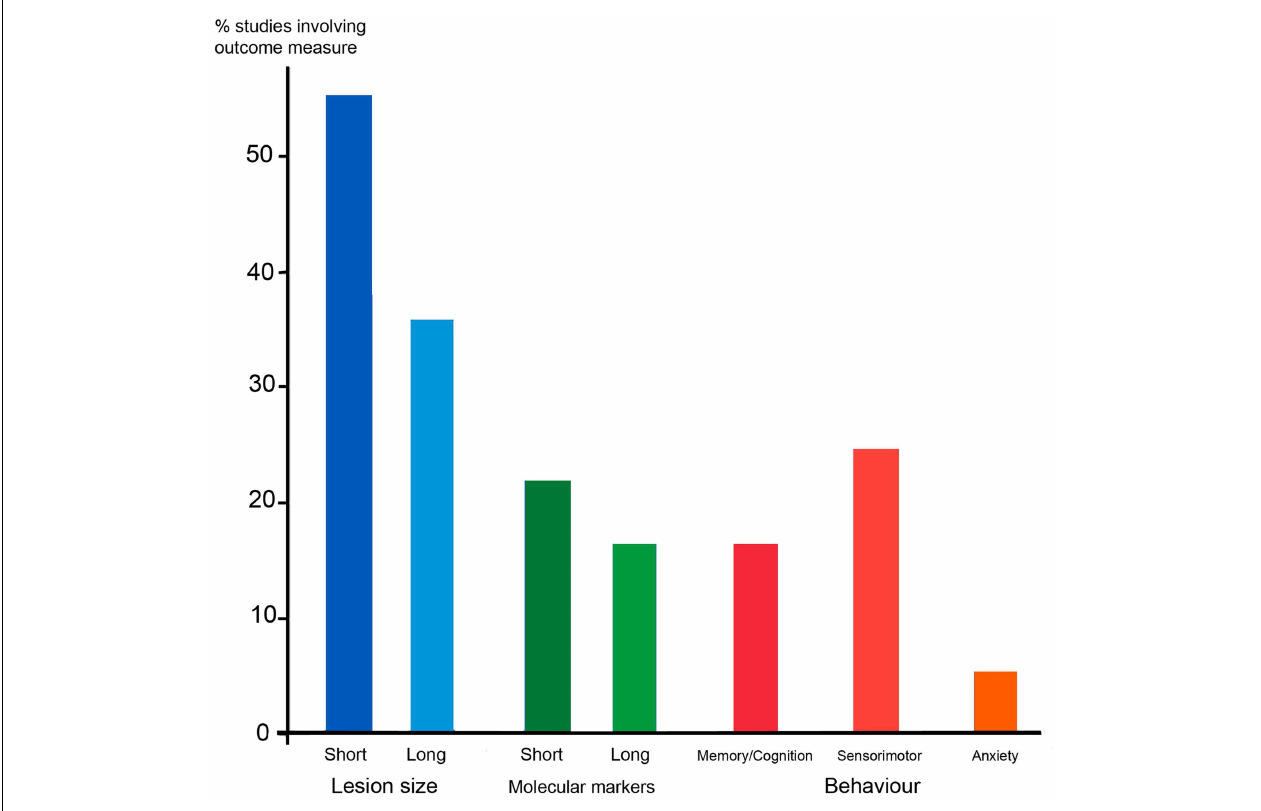
gliosis. Red/orange shows behavioral testing in adolescent or adult animals following perinatal lesions.These are divided into tests of memory and cognition (e.g., mazes) sensorimotor (e.g., rotarod, reaching, and ladder walking) and anxiety (open field).The 36 studies sampled are those involving rodents cited in Sections “Models of PeriventricularWhite Matter Injury” and “Models of Perinatal Ischemic